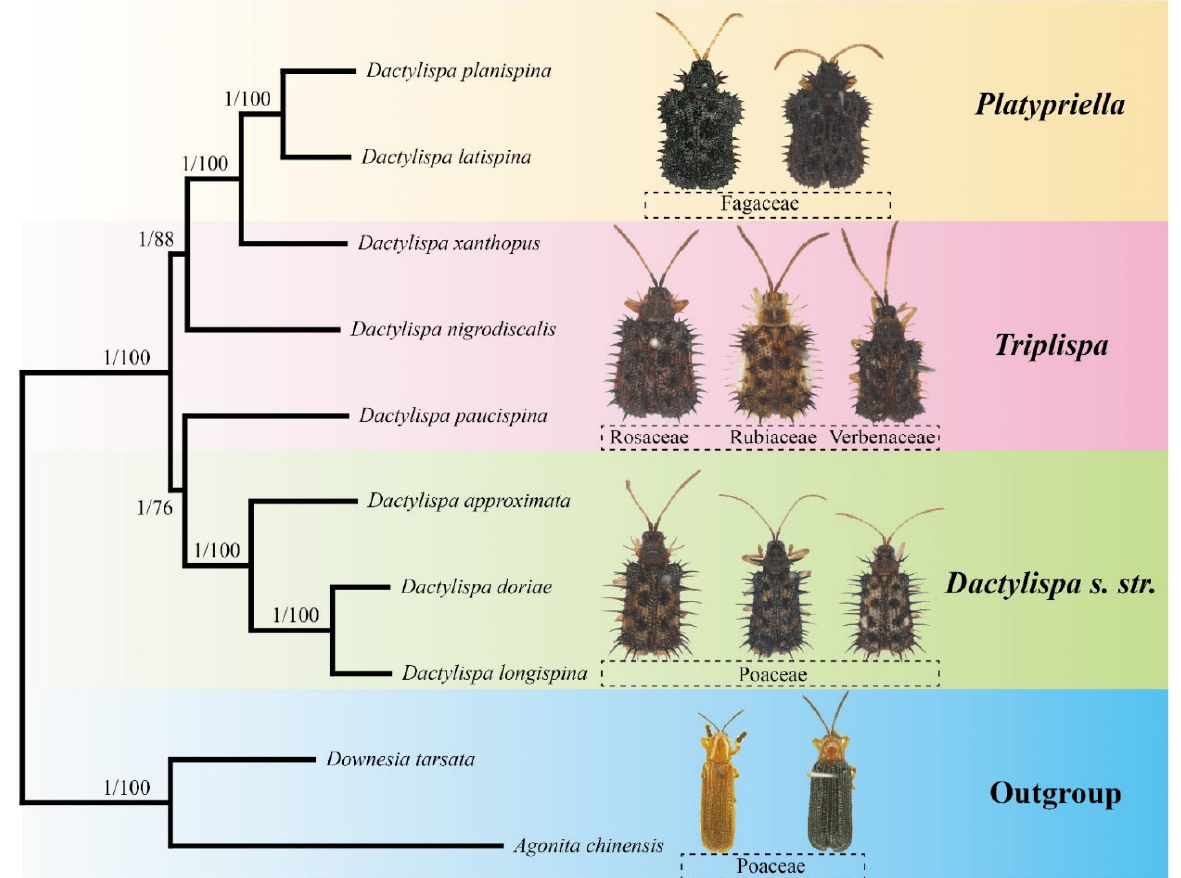
Figure 6. Phylogenetic tree of eight Dactylispa species based on complete PCGs, rRNAs, and tRNAs, with two Gonophorini species as the outgroup. Bootstrap values for the maximum likelihood (ML) analysis ( left ) and posterior probabilities for the Bayesian inference (BI) analysis ( right ) are shown for each node. Adults and their host plant families are also shown alongside the species names.